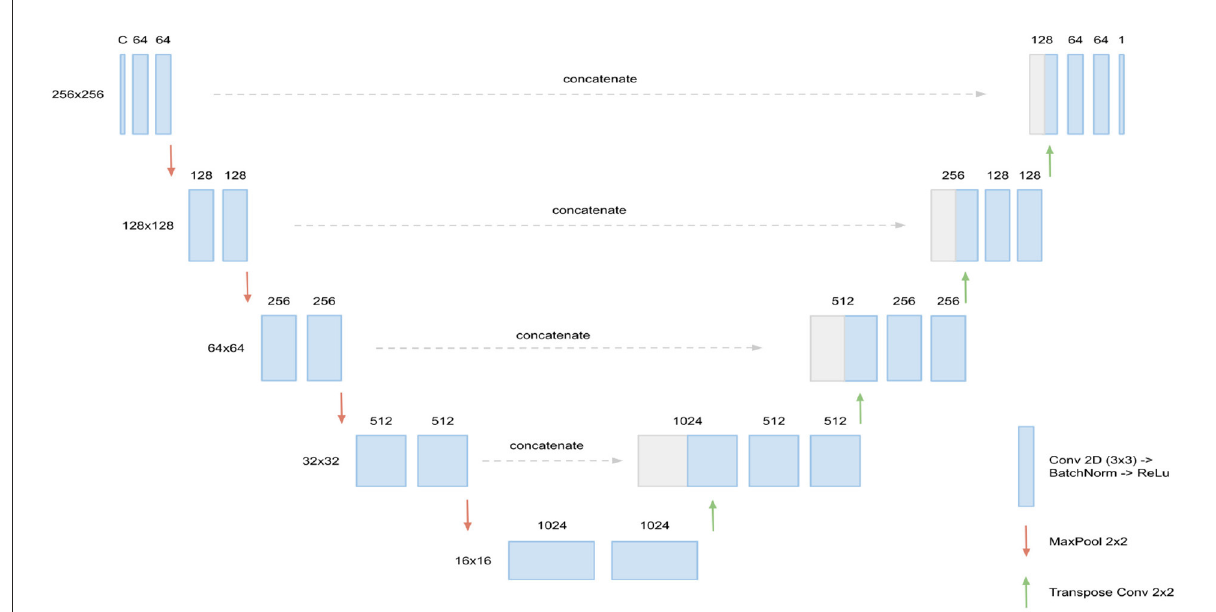
FIGURE1 Architecture of the 2D U-Net used. Input are C = 2 slices (axial, coronal, or sagittal) corresponding of dimension 256 × 256, corresponding to the two FLAIR time points. In every layer of the encoding branch (left), two convolution blocks, consisting of Conv2D (3 × 3), BatchNorm, and ReLU activation, are applied. When passing to a new layer, dimensions are reduced to half by max pooling while the number of channels is doubled in the first convolution block. In the decoding branch (right), the max pooling operations are replaced by transpose convolutions for upsampling and the data from the corresponding layer of the encoding branch is concatenated through skip connections. Output of the U-Net is the 256 × 256 binary mask containing the new lesions